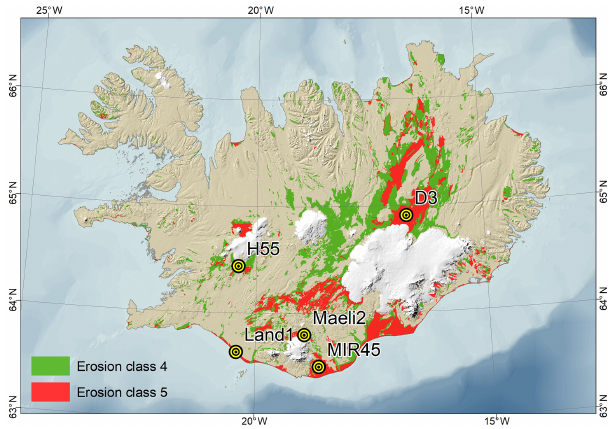
Figure 1. Surface sediment sampling sites and major dust hotspots. D3, Dyngjusandur hotspot; H55, Hagavatn hotspot; Land1, Landey- jarsandur; Maeli2, Mælifellssandur; MIR45, Mýrdalssandur. In green are the unstable sandy areas. In red are the very unstable sandy areas. Note that the map was prepared by Ólafur Arnalds using data created and owned by him at the Agricultural Univer- sity of Iceland, older works (database housed by the Agricultural University of